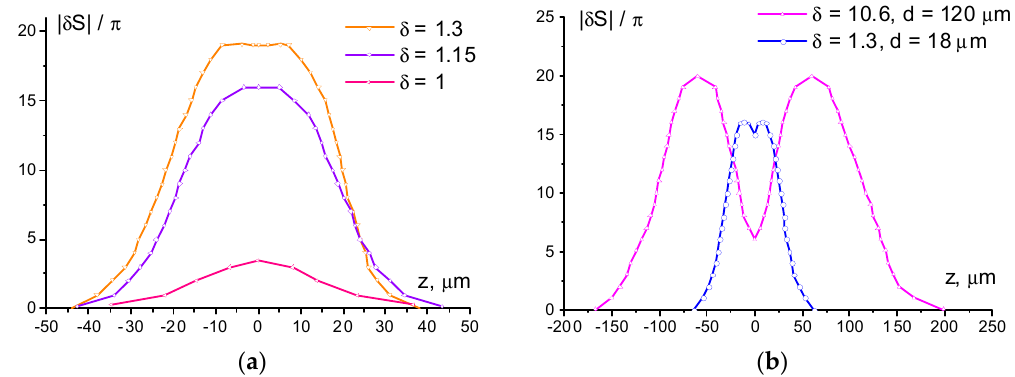
Figure 6. The phase shift reconstructed from the microphotographs shown in Figure 5 for d = ( a ) 11 and ( b ) 18 and 120 μ m. Lines are an eye-guide connecting the experimental points.